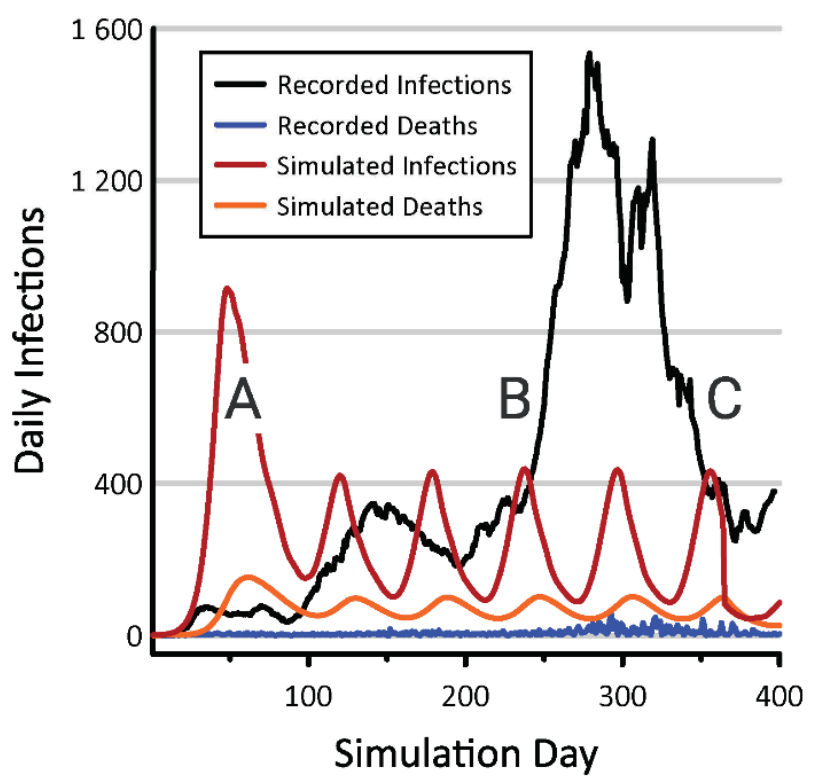
Figure 3. Numbers of new infections and deaths emerging from the spatial model incorporating social distancing (red and orange lines) and from Oregon COVID-19 records compiled by the New York Times (black and blue lines) [50]. COVID-19 testing in Oregon has been minimal throughout the pandemic, but was near zero when the disease began increasing within the state’s major metropolitan centers (A). The spread of COVID into rural parts of the state coincided with the 2020 holiday season, during which rates of viral transmission increased (B). Better adherence to human health guidelines in rural and suburban parts of Oregon contributed to a subsequent decline in cases (C). The VUR deployment strategy (Table 3) produced the least benefit of our five spatial vaccination experiments (Figure 4). Under this strategy, the number of new infections per day remained quite large at times. In contrast, the VUU deployment strategy exhibited the greatest vaccination efficacy. Under the VUU strategy, daily new infections fell to roughly four individuals for much of the final simulation year. Our three prioritized vaccination deployment strategies (VPC, VPR, and VPD) produced a number of new infections ranging between 40 and 130 per day (Figure